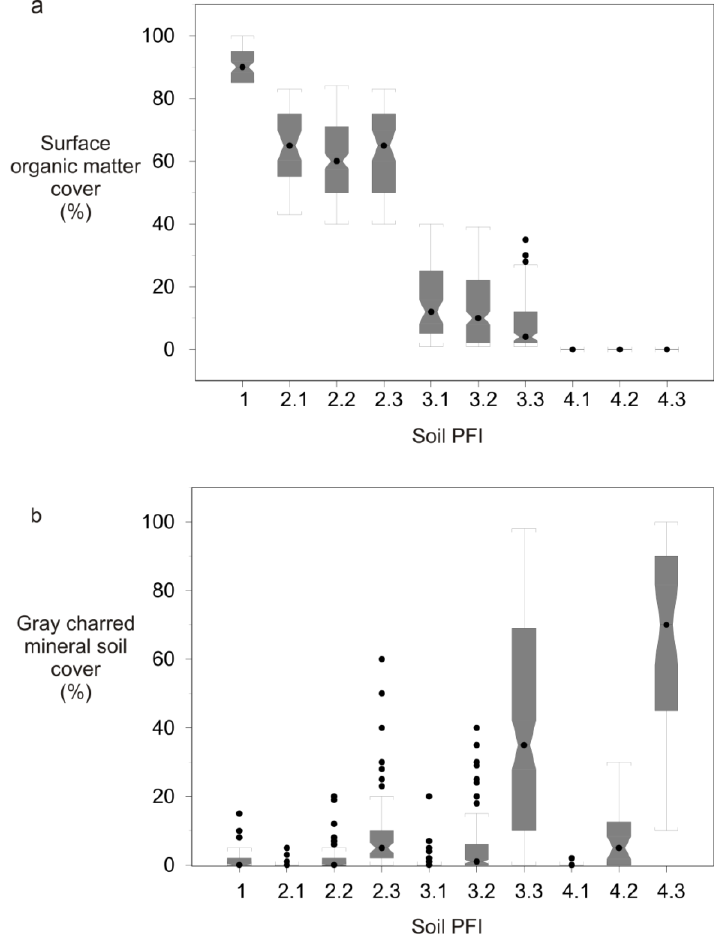
Figure 1. For the 950 plots, the 25% and 75% quartiles (box bottom and top), confidence level (hour-glass), median (center dot), range (upper and lower T-bars), and outliers (dots) are displayed for percent surface organic matter cover ( a ) and percent grey colored mineral soil ( b ) by post-fire index (PFI)